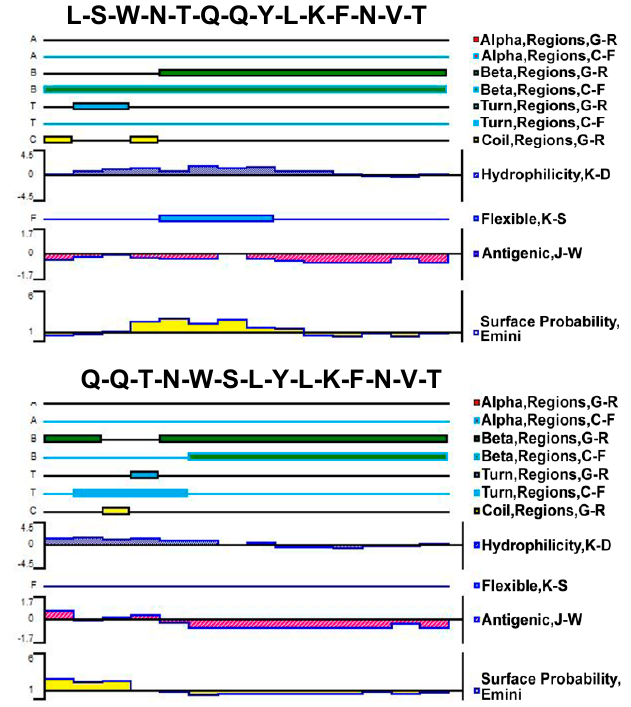
Figure 1. Predicted secondary structures, flexibility plots, hydrophilicity plots, surface probability plots, and antigenicity index for the 14-mer polypeptides.